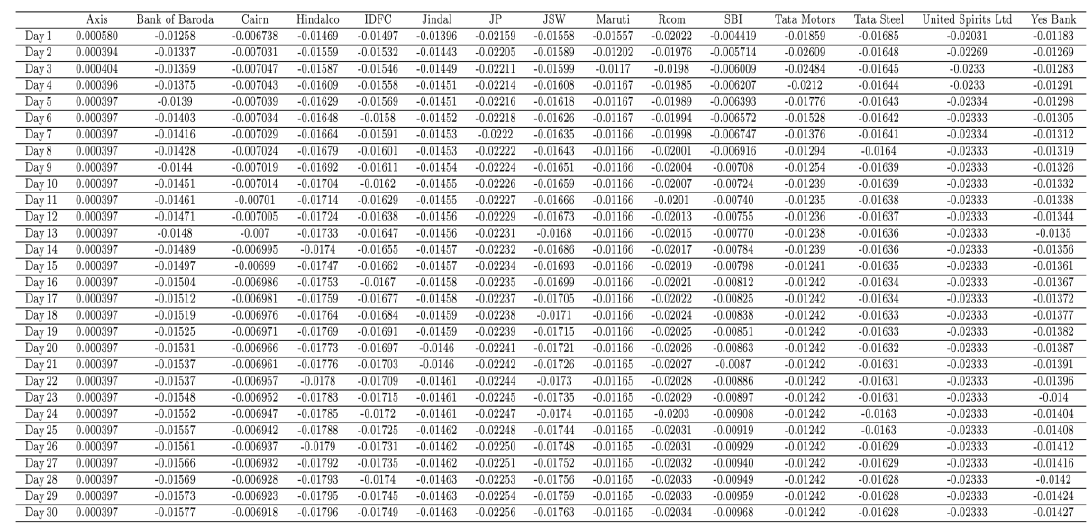
Table 5. The forecasted returns (daily low) for the month of March